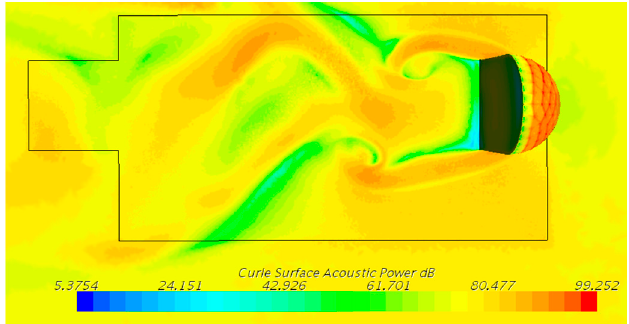
Figure 9. Distribution of sound sources on the side mirror and Curle surface of the panel.